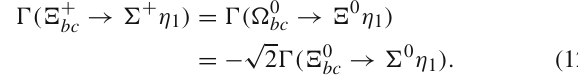
Fig. 1 Feynman diagrams for W -exchange. The first three diagrams exhibit that light meson SU ( 3 ) octet in the final state while the last one shows the SU ( 3 ) singlet. If the final state u quark replaced by c , these